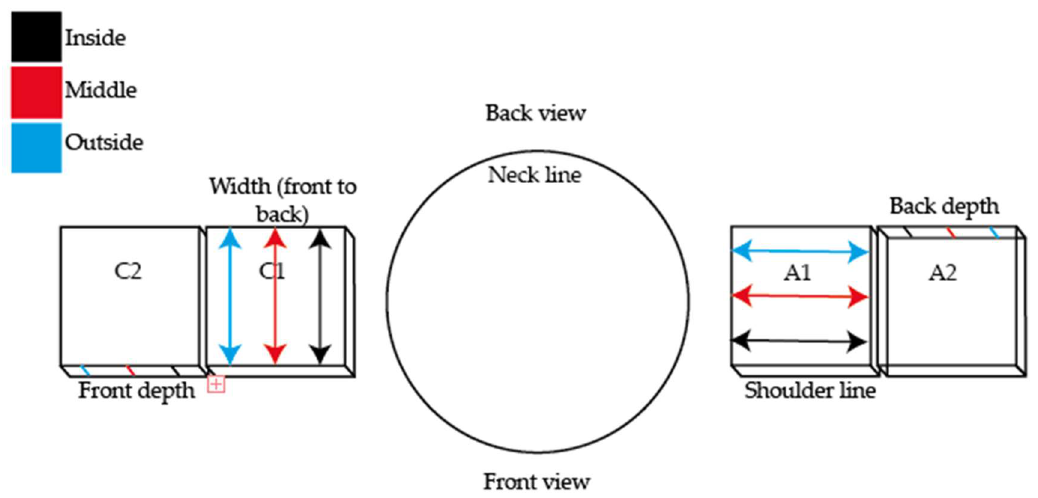
Figure 1. Diagram to display the shoulder padding positions of the conventional foams (C1 and C2) and auxetic foams (A1 and A2) and a key reference for the measurement positions of the front view depth, width, shoulder line and back view